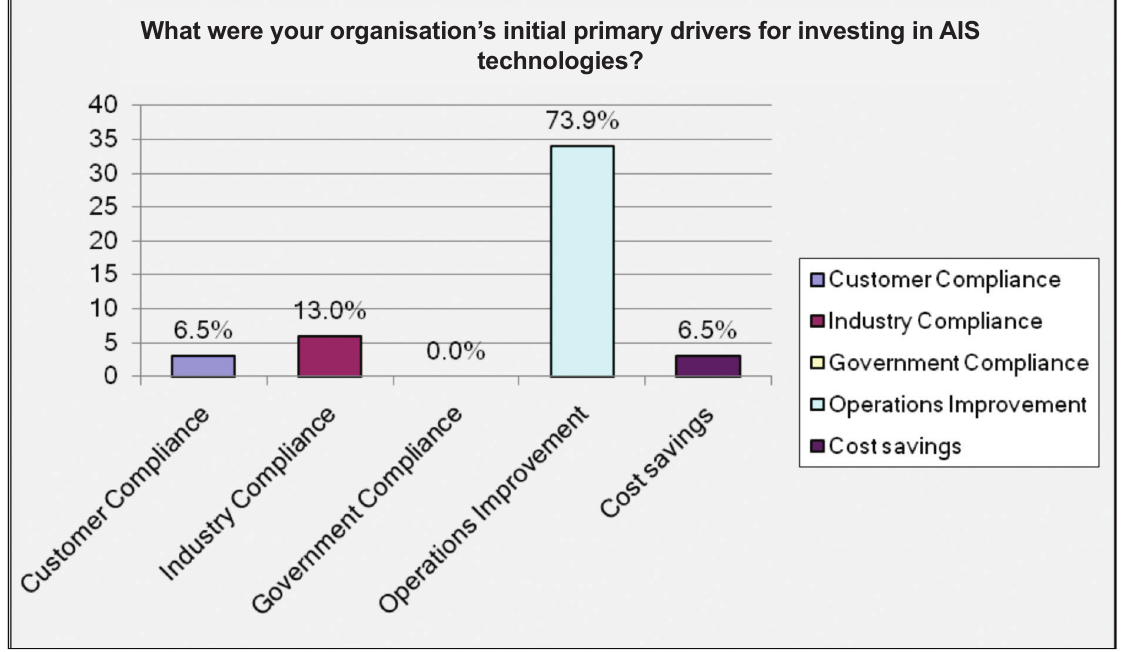
Figure 1: Primary drivers for investing in AIS